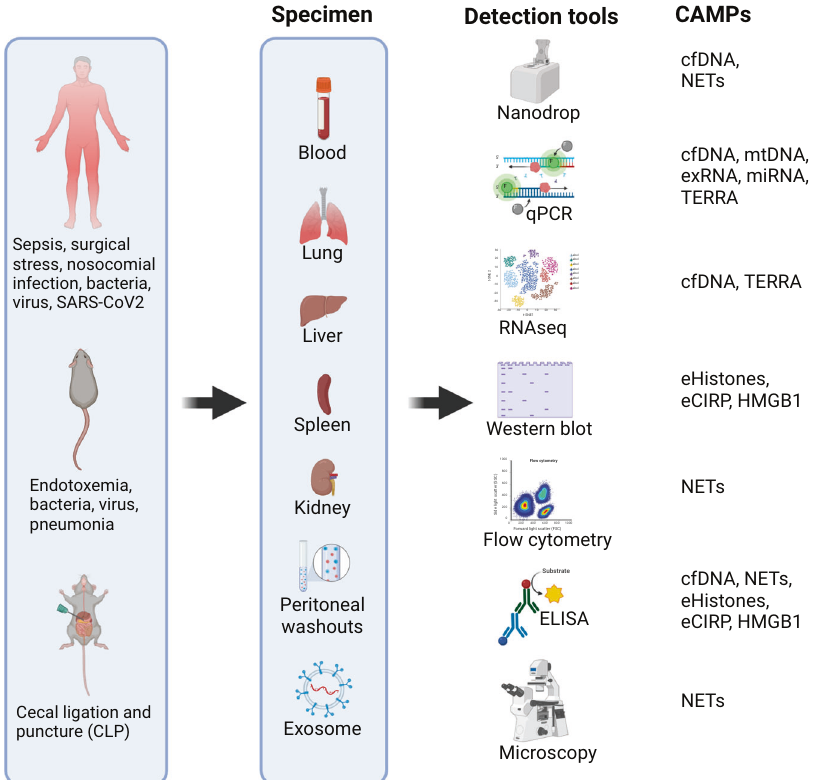
Fig. 3 Detection of CAMPs in sepsis. For diagnostic and prognostic purposes, various samples of human and murine sepsis can be used to detect CAMPs using several immunological and molecular biological assay tools. CLP Cecal ligation, and puncture, NETs Neutrophil extracellular traps, eCIRP Extracellular CIRP, CAMPs, chromatin-associated molecular patterns; exDNA Extracellular DNA, mtDNA Mitochondrial DNA, TERRA Telomeric repeat-containing